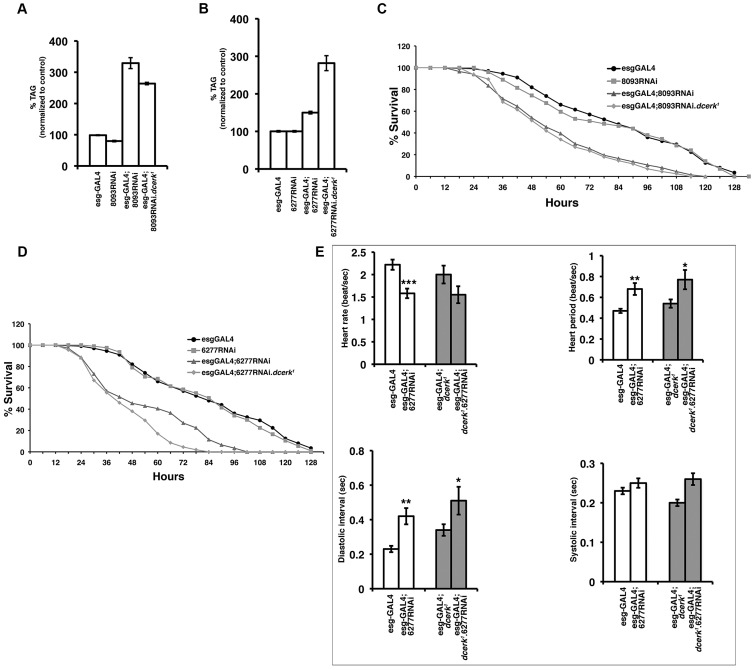
Knockdown of CG8093 and CG6277 in the midgut increases whole body TAG, starvation sensitivity in w1118 and dcerk1 flies and knockdown of CG6277 also leads to cardiac defects.(A). Midgut specific reduction in CG8093 increases whole body TAG level to 325–350% in control w1118 flies and about 275% in dcerk1 mutants. The TAG level of driver is taken as 100%. n = 3, error bars represent standard deviation. (B). Midgut specific reduction in CG6277 increases whole animal TAG to 150% in control w1118 flies and about 275%–300% in dcerk1 mutants. The TAG level of driver is taken as 100%. n = 3, error bars represent standard deviation. (C). Reduction in CG8093 lipase increases the starvation sensitivity of wild type and dcerk1 flies. CG8093 RNAi flies, esgGAL4 driver flies, 8093 RNAi combined to esgGAL4 in wild type and dcerk1 are subjected to starvation and the number of surviving flies is recorded at 6 hr intervals. 200 flies divided into 10 groups for each genotype are used in one experiment. Three independent experiments are performed and the average percentage survival is shown for each time interval. (D). Reduction in CG6277 lipase increases the starvation sensitivity of wild type and dcerk1 flies. CG6277 RNAi flies, esgGAL4 driver flies, 6277 RNAi combined to esgGAL4 in wild type and dcerk1 are subjected to starvation and the number of surviving flies is recorded at 6 hr intervals. (E). Quantification of cardiac function parameters in RNAi knockdown of CG6277 in wild type and dcerk1. Knockdown results in decreased heart rate in wild type flies and a similar trend in dcerk1, increased heart period in both backgrounds, longer diastolic interval in control and mutant and no significant change in systolic interval. n = 11–13 for each group. Bar represents standard error of mean and statistical significance was determined using Student's t test; * denotes P< = 0.05-0.01, ** is P< = 0.01-0.001 is and *** denotes P< = 0.001-0.0001.